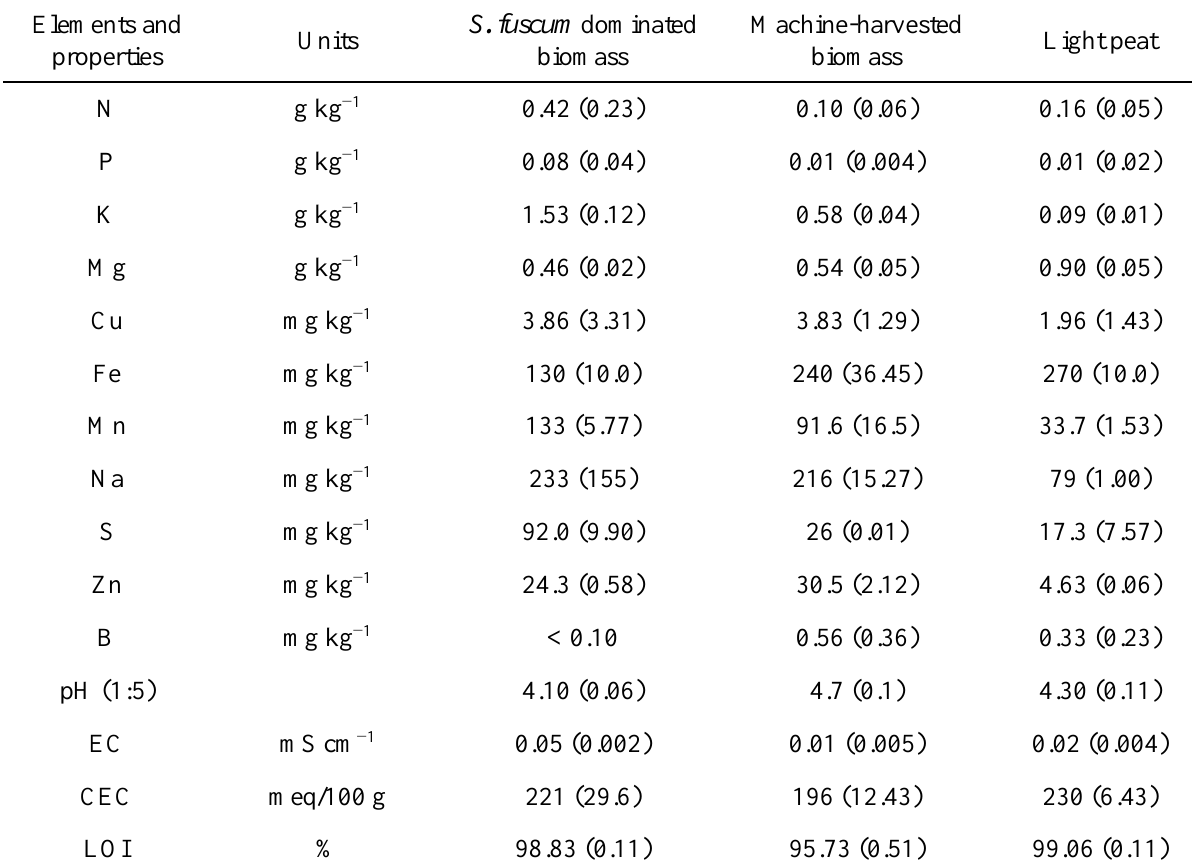
Table 1. Soluble mineral nutrient contents and chemical properties for the dry matter of Sphagnum biomass dominated by S. fuscum , machine-harvested Sphagnum and light Sphagnum peat. Standard deviation is given in brackets.